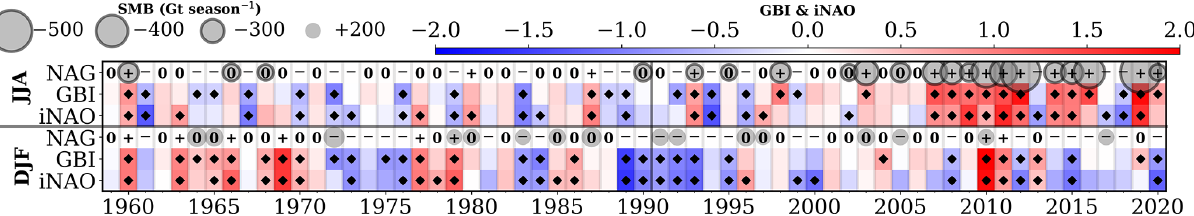
Figure 2. Time-series of seasonal GBI, signal inverted NAO (iNAO) and NAG. GBI and iNAO phases are color-coded; NAG is coded by symbols shown as positive (+); neutral (0); and negative ( − ) phase. The negative (positive) GBI and iNAO phase based on the 25th (75th) per- centile are illustrated as diamonds. Seasonally accumulated surface mass balance (SMB) for absolute quantities larger than 200Gtseason − 1 (winter DJF and summer JJA) is sized accordingly. A negative SMB is marked by a dark circle around the bubble. For reference, 1991 is highlighted as a gray vertical line to illustrate GBI, NAO and NAG